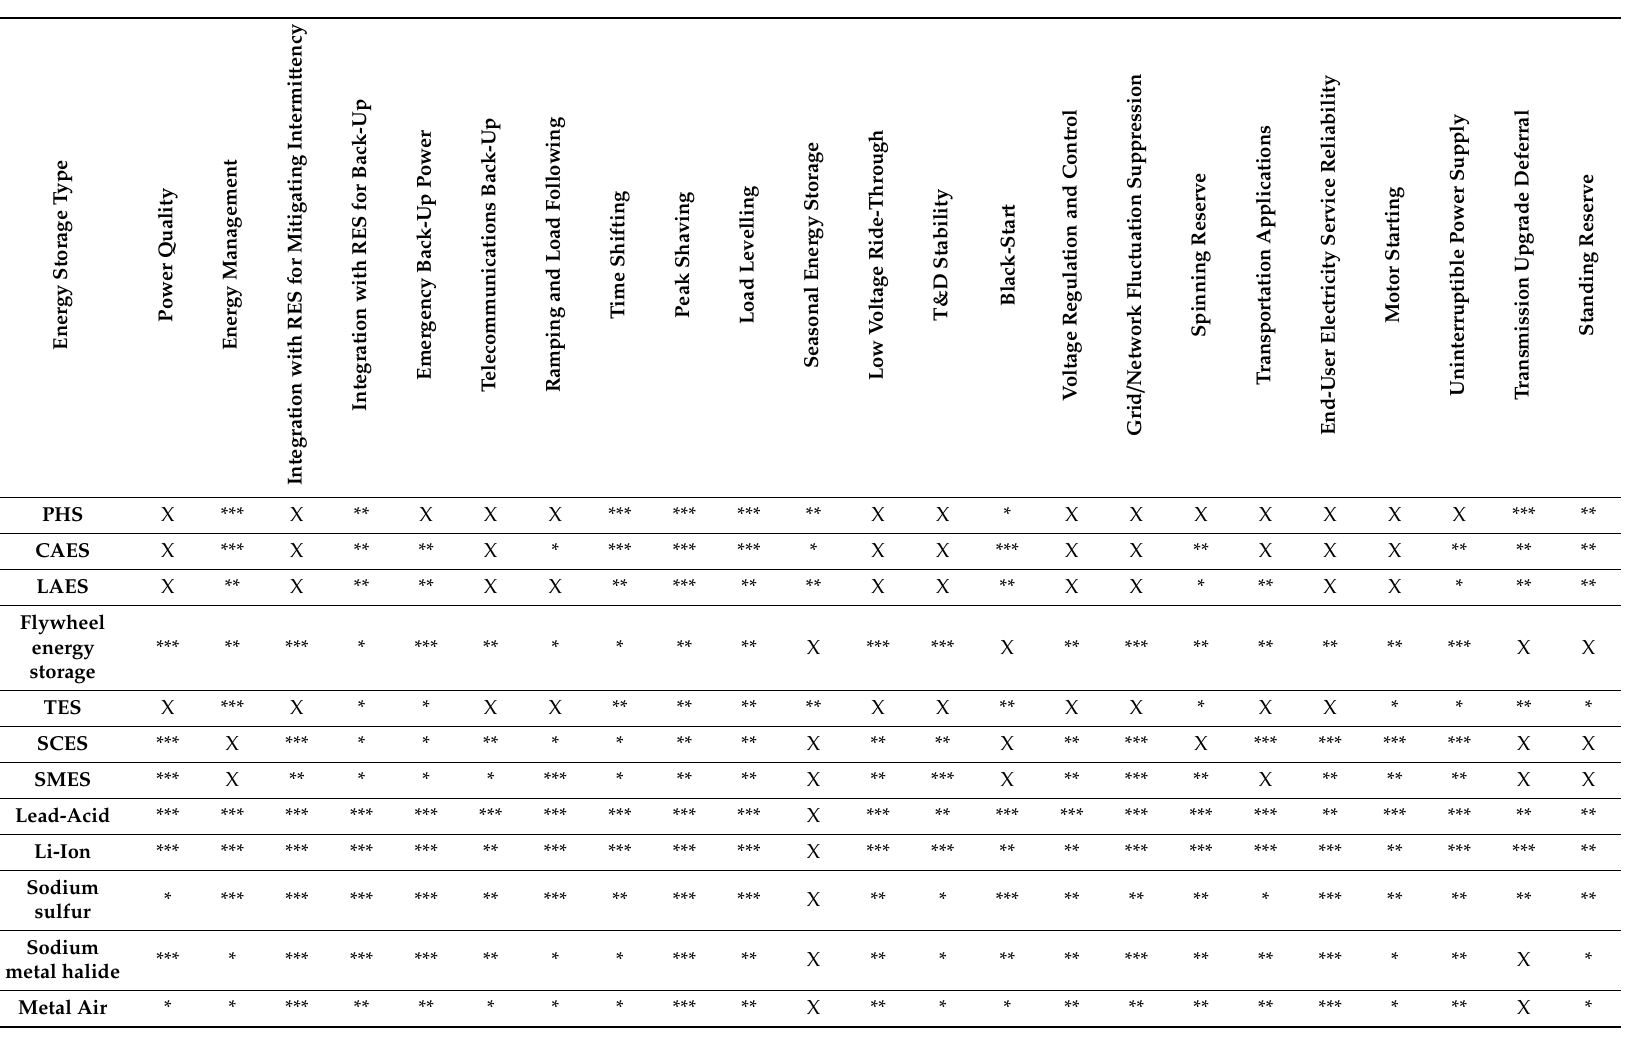
Table 19. The suitability of di ff erent energy storage systems for various